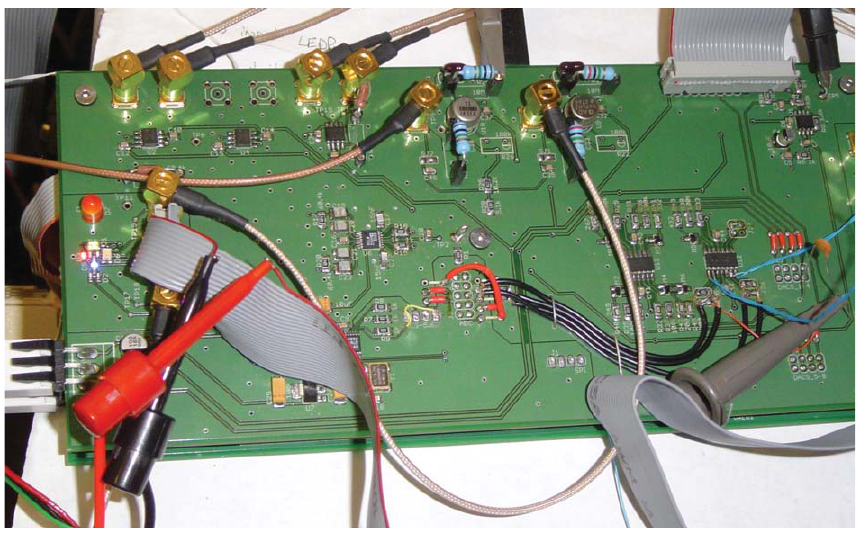
Fig. 6. A photograph of the analog signal conditioning board mounted to the data acquisition